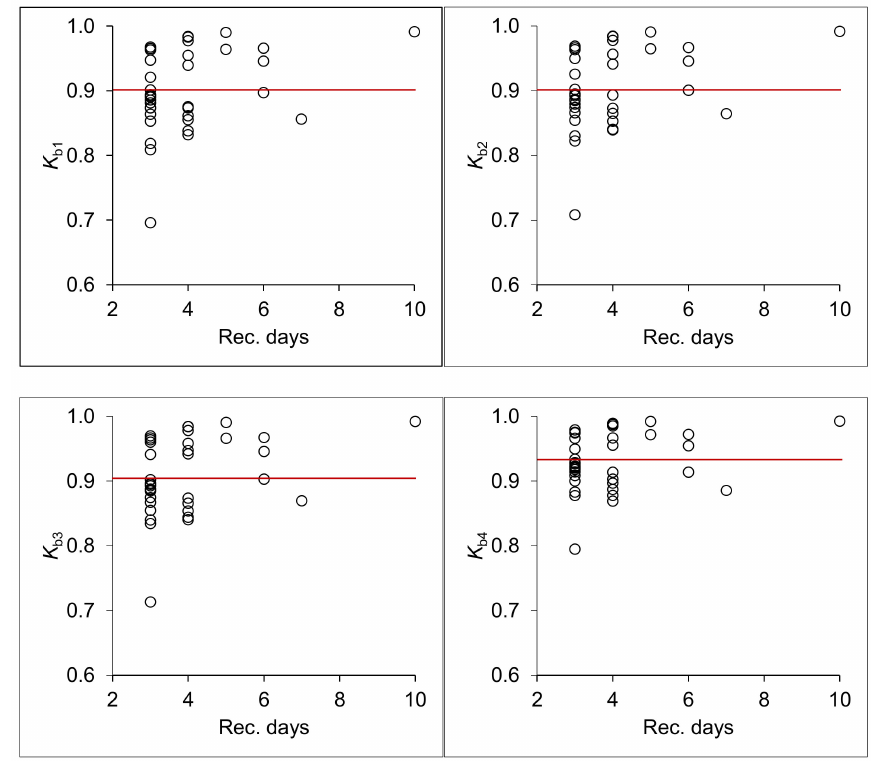
Figure 4. K versus recession days. Red line is the mean.